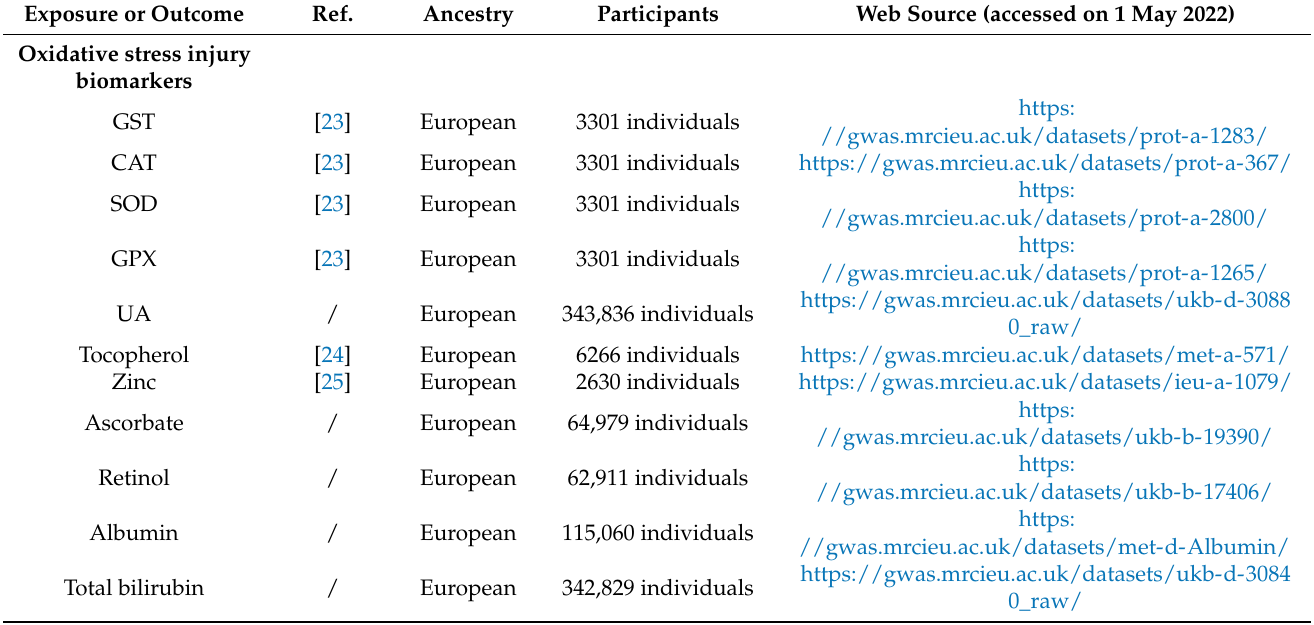
Exposure or Outcome